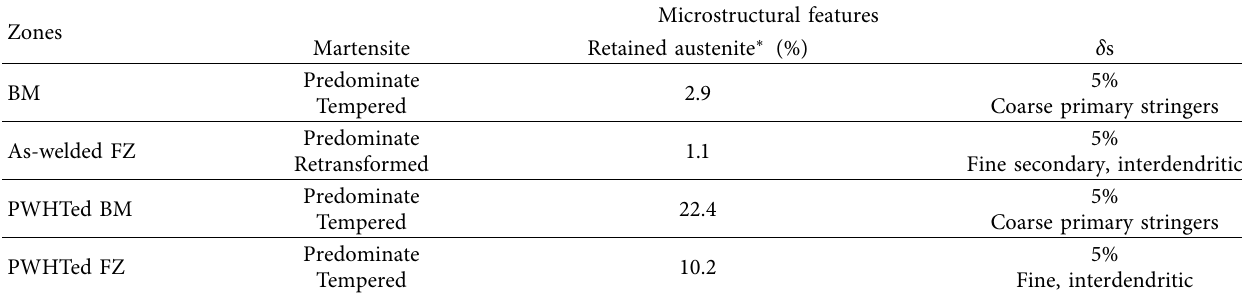
Table 2: Microstructural characteristics of CA6NM before EBW, after EBW, and after PWHT. Zones